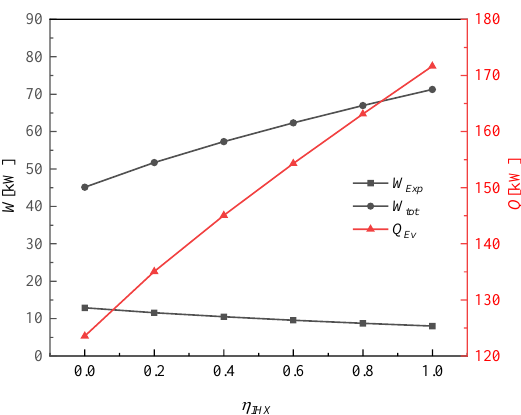
Figure 5. Effect of η IHX on system power consumption and cooling capacity.